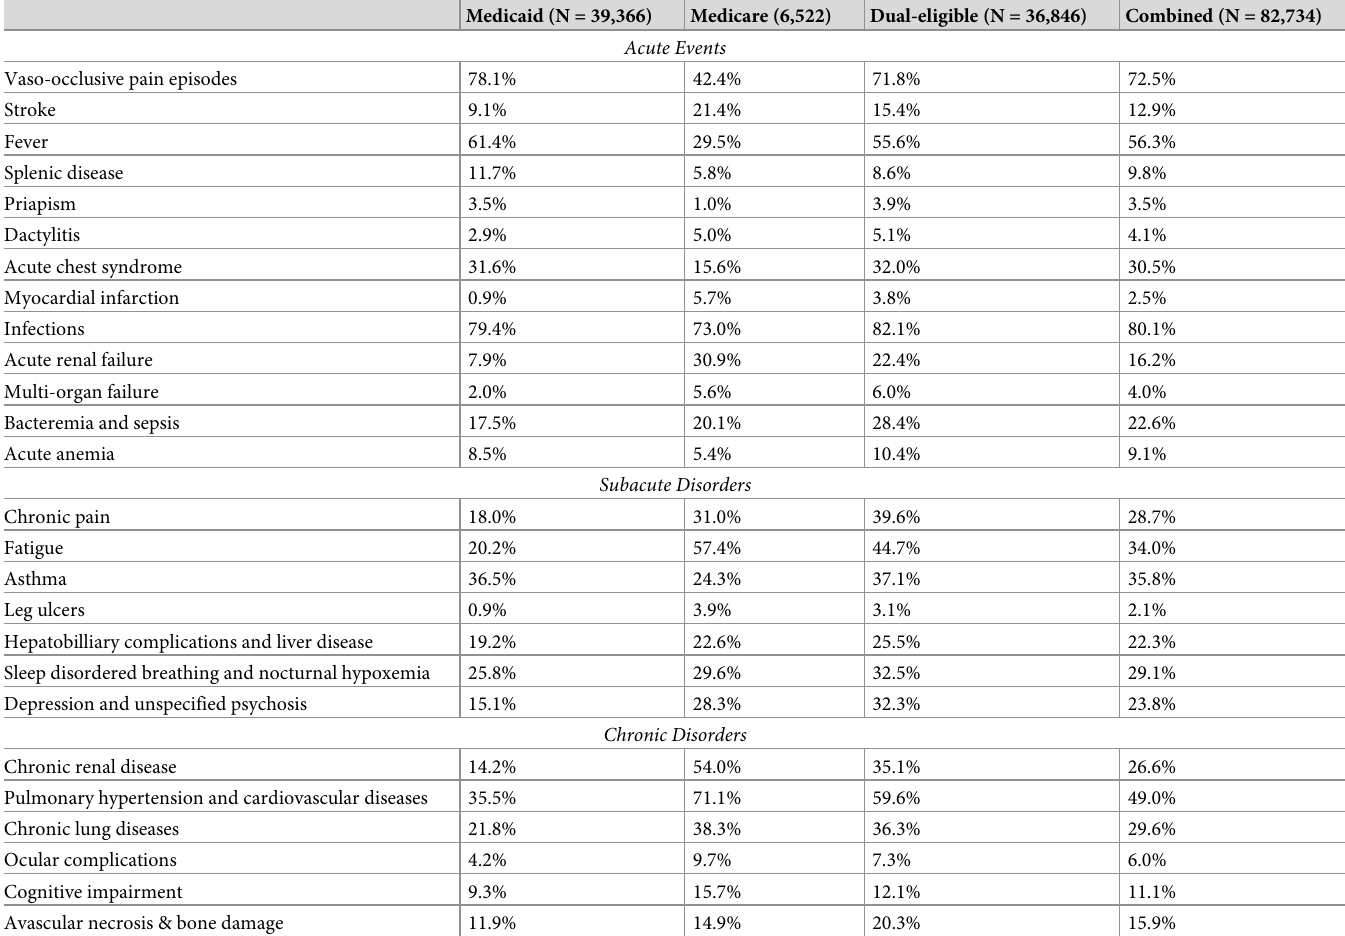
Table 2. Lifetime prevalence of disease attributes among individuals diagnosed with SCD in Medicaid, Medicare, and dual-eligibility